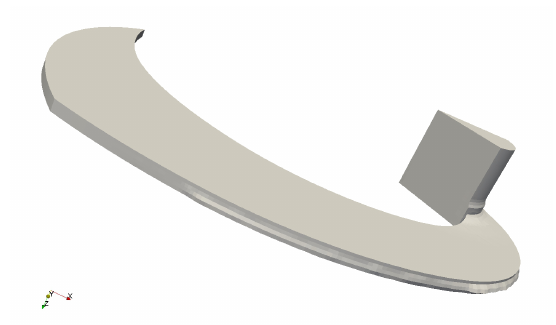
Figure 7: Pump channel close up before deformation.